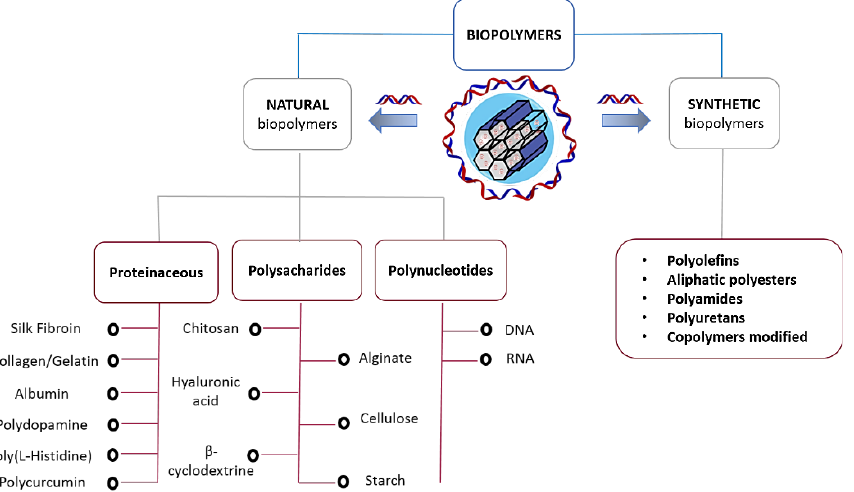
Figure 1. General classification of biopolymers used as capping agents for stimuli-responsive MSNs.